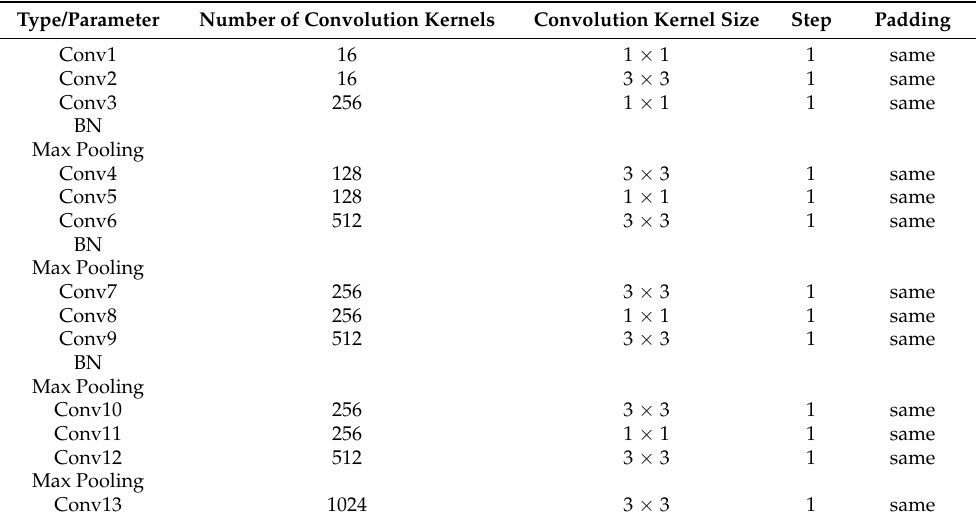
Table 1. Network structure and parameters of improved feature extraction module.